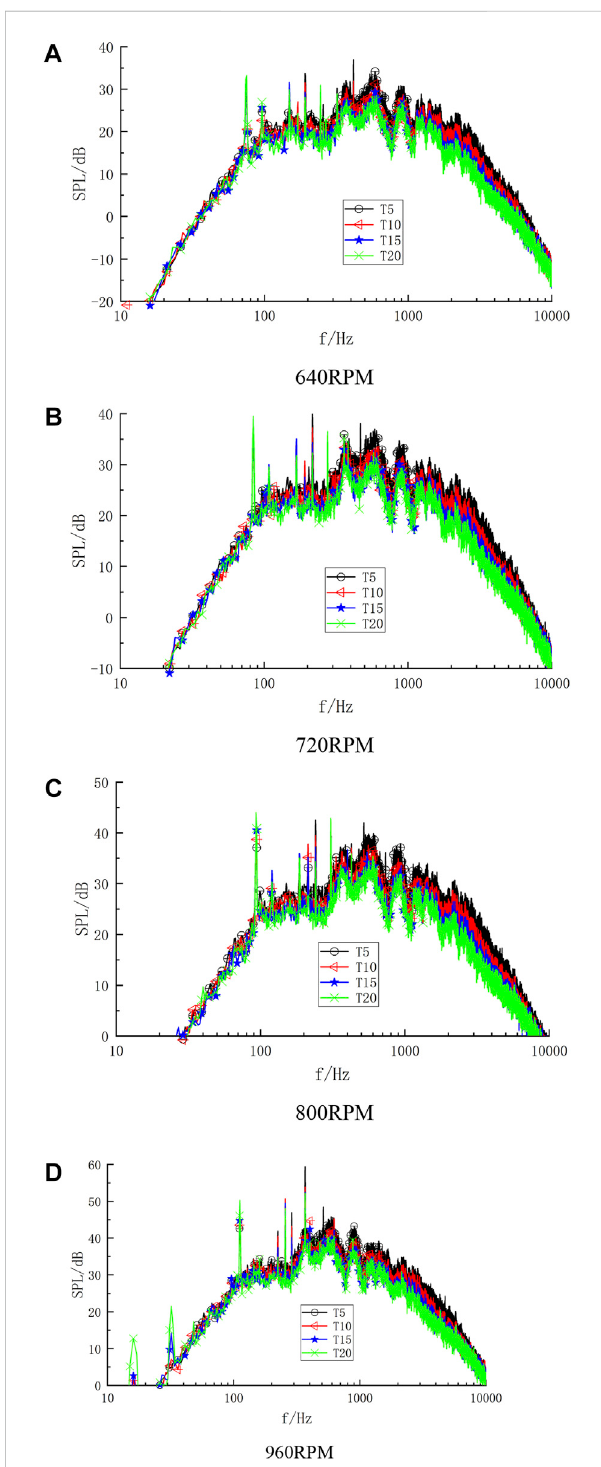
FIGURE 13 SPLspectrumof thecontra-rotating axial fanwith differentblade thicknesses: (A) SPL under 640RPM; (B) SPL under 720RPM; (C) SPL under 800RPM; (D) SPL under